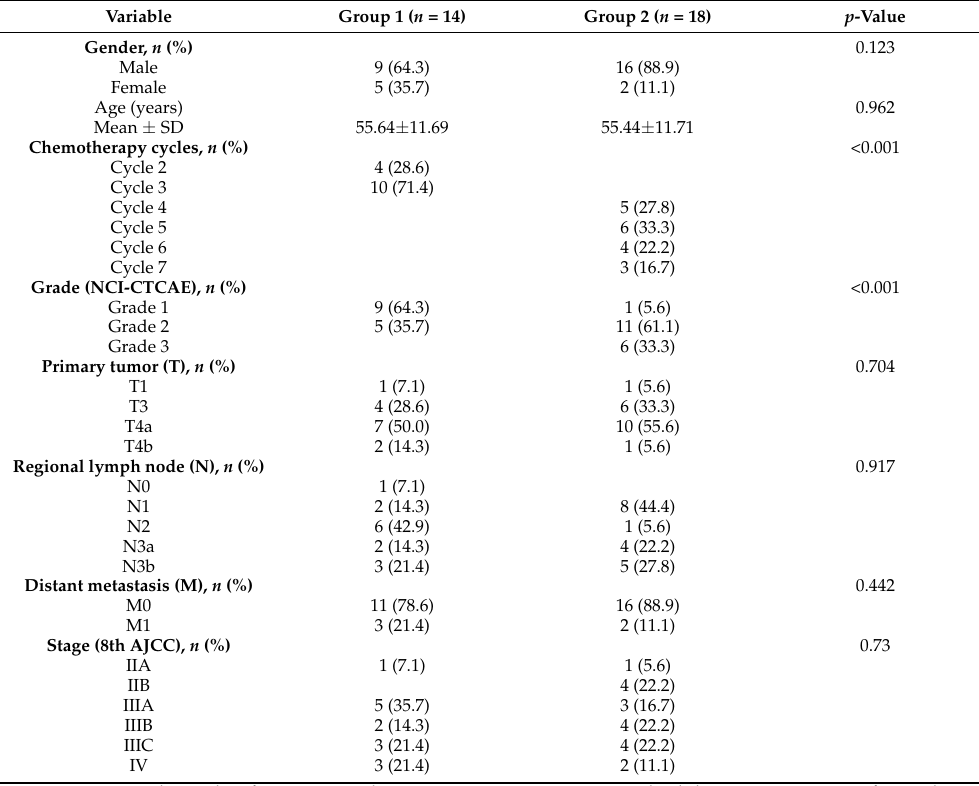
Table 1. Clinicopathological features of GC patients with XELOX chemotherapy.